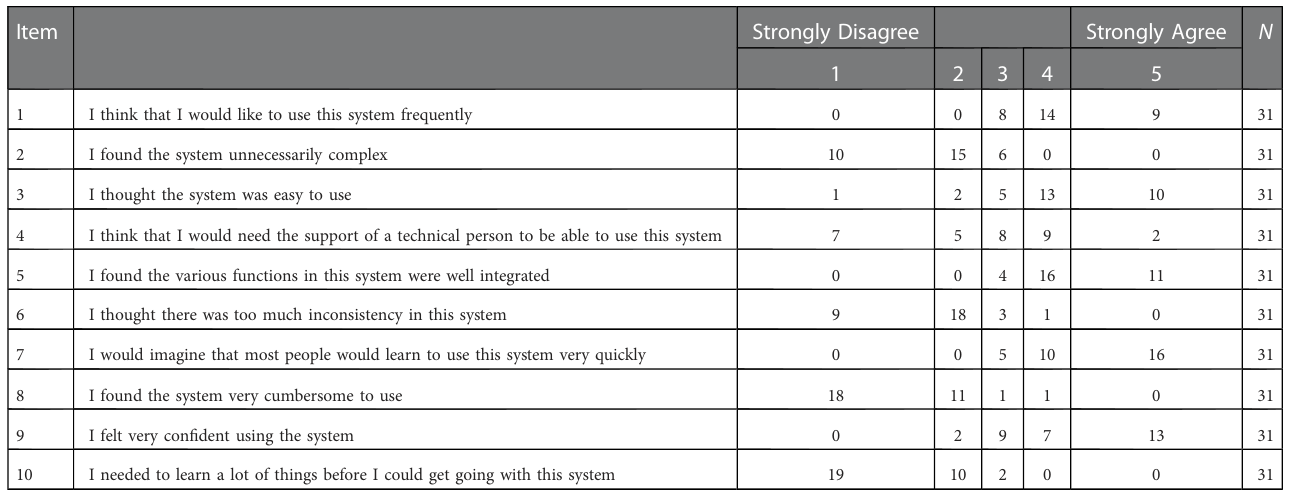
TABLE 2 Summary of system usability scale results.